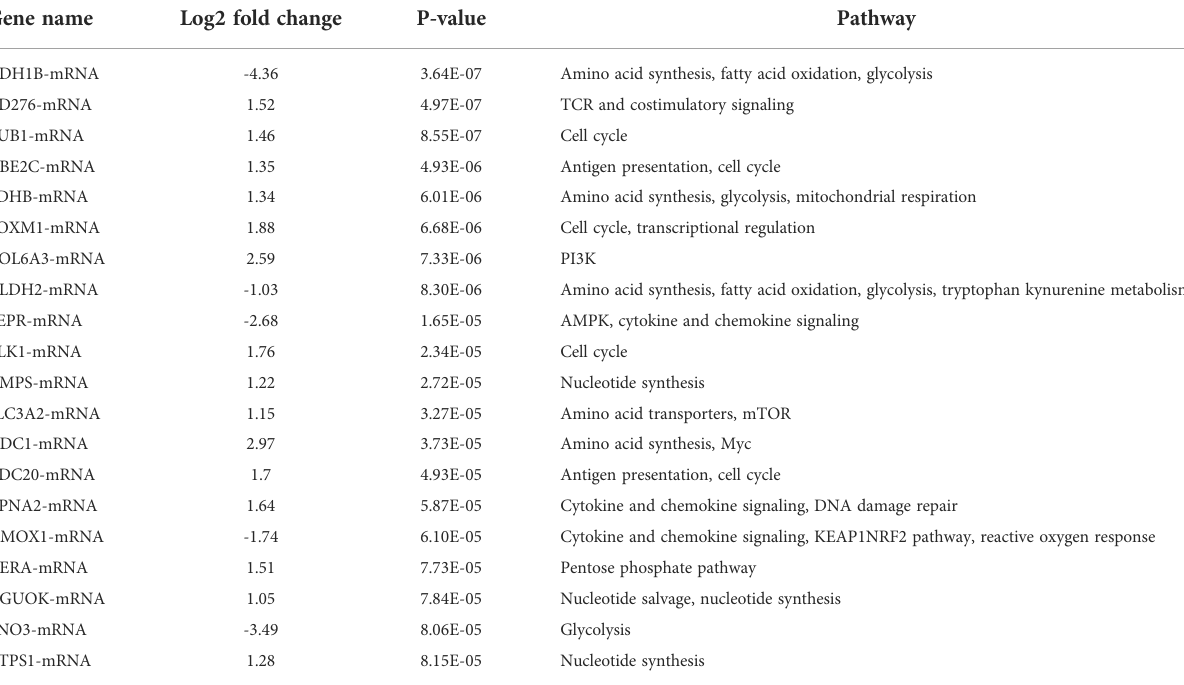
TABLE 1 Analysis of genes with the most signi fi cant difference in nCounter ® Metabolic Pathways Panel between HSCC and adjacent normal